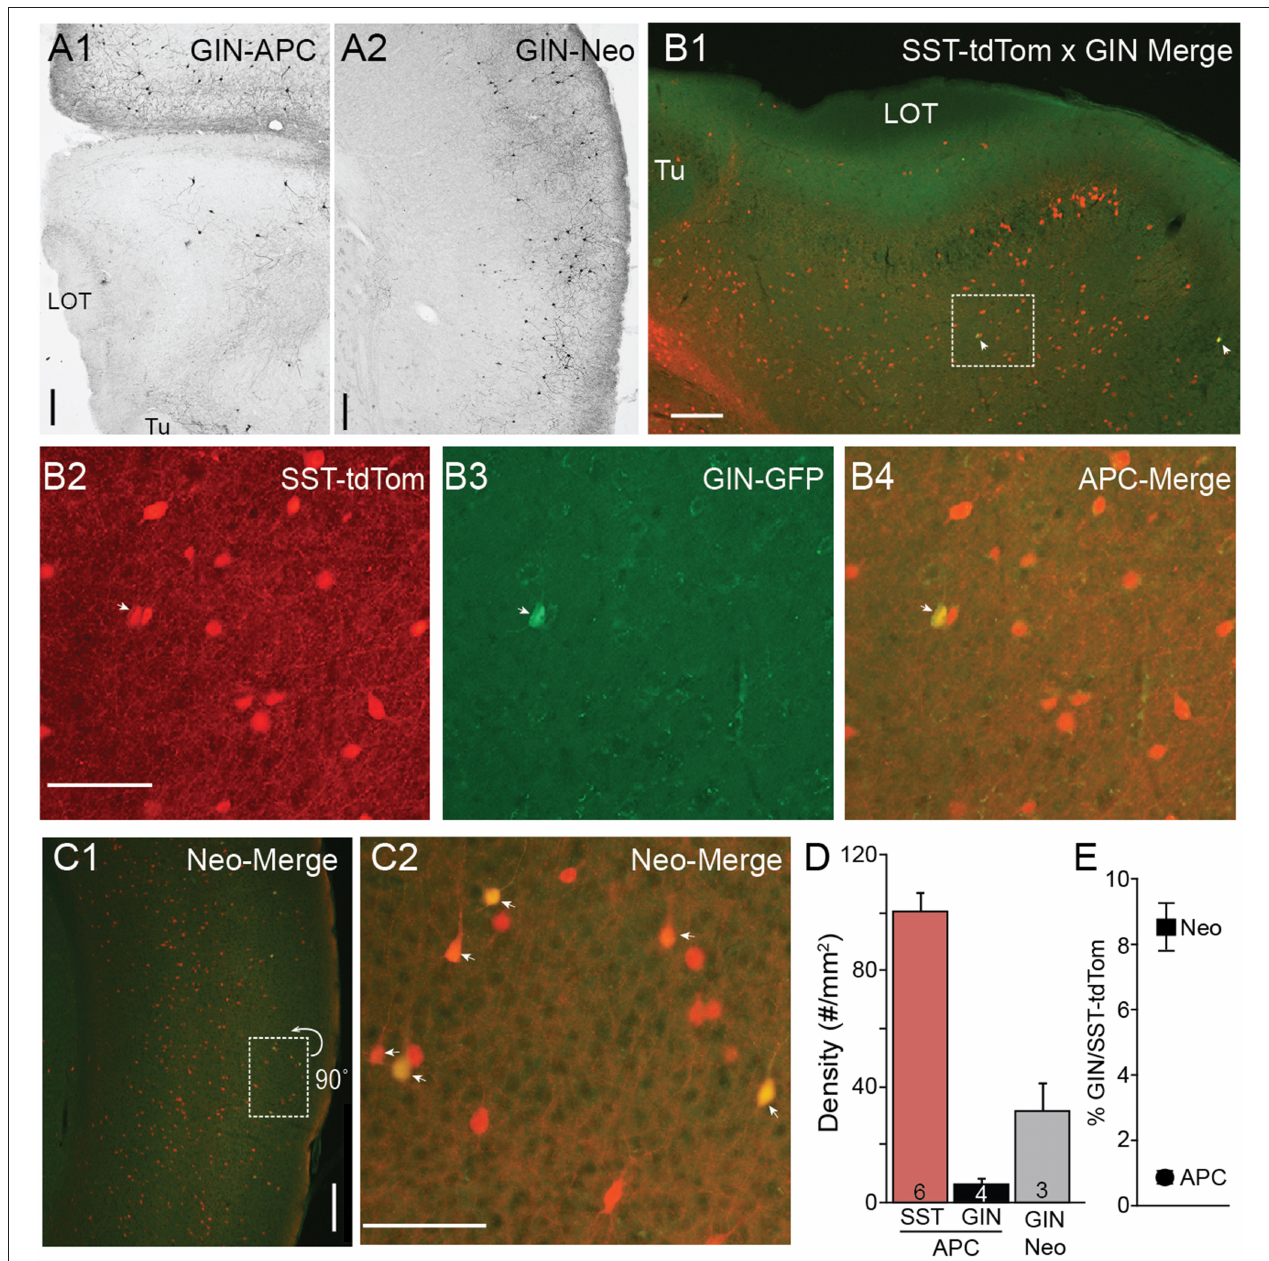
FIGURE 2 | Minimal co-expression of GFP and tdTom in GIN and SST-cre lines. (A) GFP( + ) GIN cells labeled using anti-GFP antibodies and DAB (see Methods) in sections of anterior piriform cortex (A1) and neocortex (Neo) (A2) from a GIN mouse. 4x magnification, Scale bar: 200 µ m. (B) Merged tdTom (SST-cre) and GFP (GIN) fluorescence in APC from an SST-tdTom-GIN mouse. White arrows indicate co-labeled cells. (B1) 4x magnification, Scale bar: 200 µ m. (B2–B4) Region shown in (B1) enlarged (20x, scale bar 100 µ m) in for SST-tdtom cells (red, B2 ), GIN cells (GFP, B3 ) and merged (B4) to show double labeled cells (yellow). Very few SST-tdtom cells double label with GIN cells in APC. (C1) Merged tdTom (SST-cre) and GFP (GIN) fluorescence in neocortex from the same SST-tdTom-GIN mouse as in B. (C2) Region shown in (C1) , enlarged (20x, scale bar 100 µ m) showing a higher proportion of SST-tdTom cells co-label with GFP( + ) GIN cells (yellow, arrows) in neocortex. Scale bars as in (B) . (D) Summary plots showing the average density of SST-tdTom cells in APC compared to GIN cells in APC and Neocortex. (E) Percent overlap between SST-tdTom and GIN cells in APC and neocortex. Tu, olfactory tubercle.